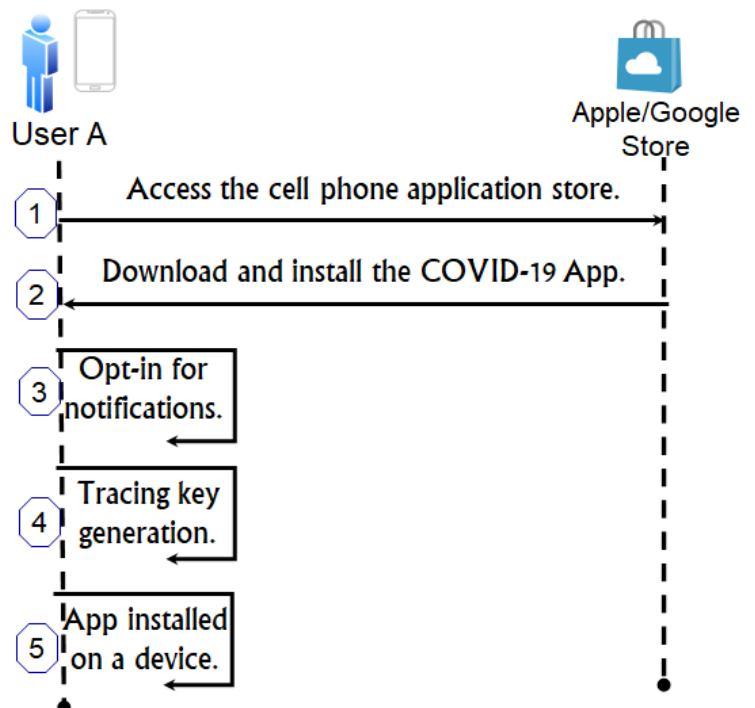
Figure 2. Installing a contact tracing app (i.e., OS-assisted ENS) on a local